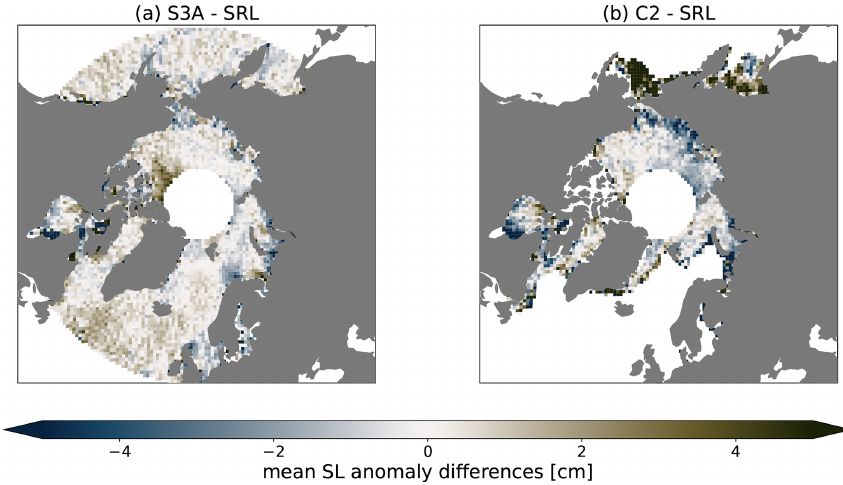
Figure 3. Maps of mean SL differences between (a) S3A and SRL and (b) C2 and SRL. Differences are estimated over the time span common to all missions (July 2016–April